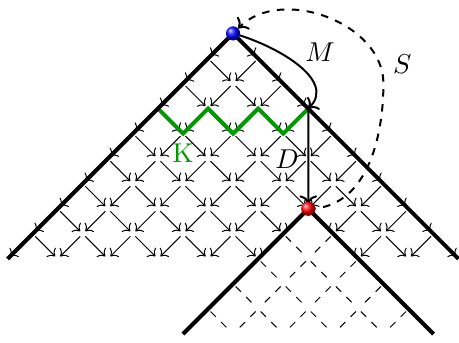
Figure 4 . Schematized crystal-version depiction for a reducible